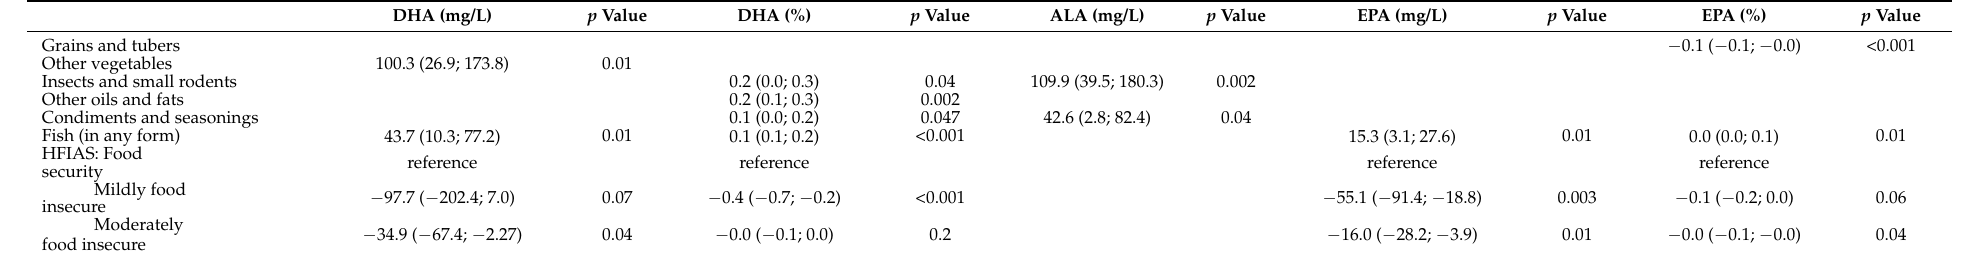
Table 6. Multilevel models of the dietary determinants of human milk fatty acids during the first 6 months of life